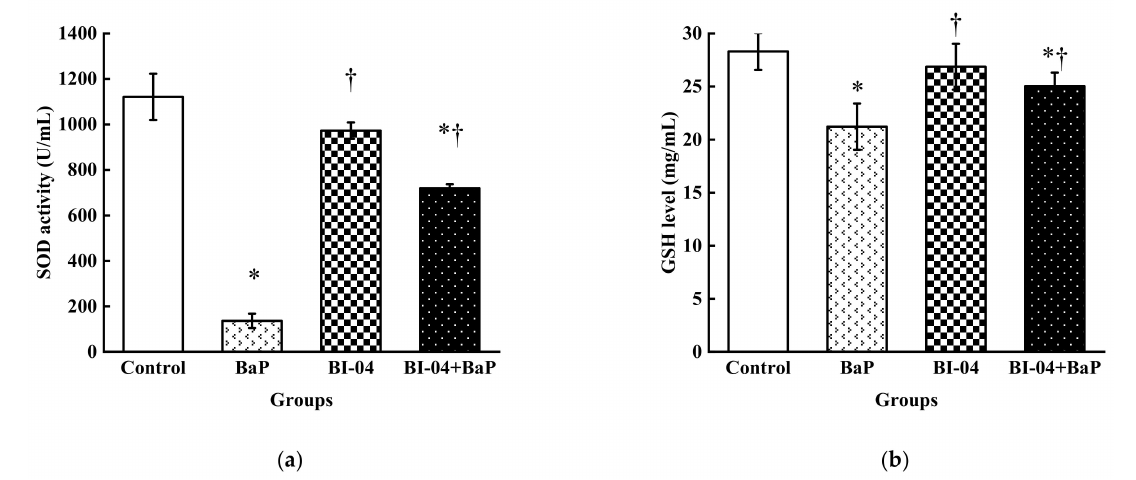
Figure 2. Performances of oxidative stresses of colon epithelial cells incubated at 37 ◦ C for 4 h in di ff erent treatment groups. ( a ) represents SOD activity of colon epithelial cells and: ( b ) is the GSH level of colon epithelial cells. The results are presented as the mean ± SD of three independent assays. (* p < 0.05, significantly from control group, † p < 0.05, significantly from